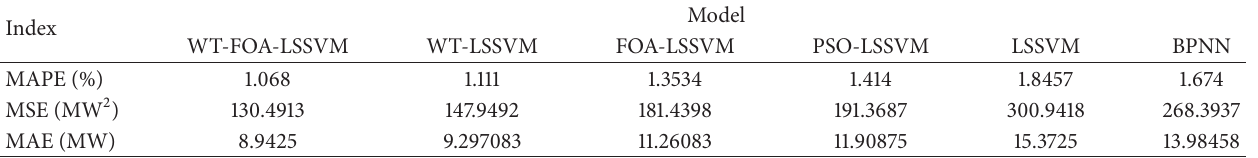
Table 4: Models performance